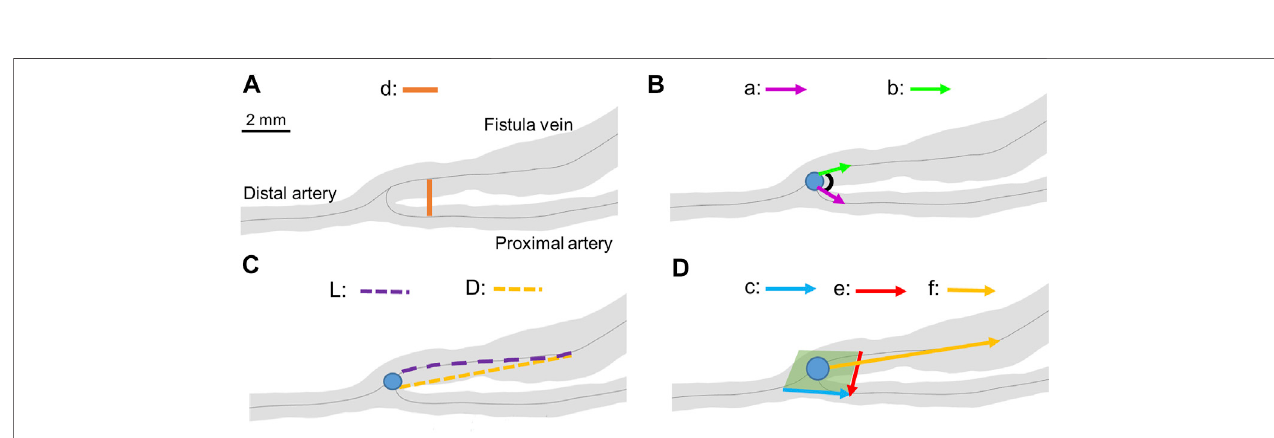
FIGURE 3 | Geometrical parameter calculations. (A) A-V distance. “ d ” represents the distance between the proximal artery and the fi stula vein. (B) Anastomosis angle. “ a ” representsvectorfromtheanastomosisorigin(bluedot)toapoint2 mmawayintheproximalartery. “ b ” representsthevectorfromtheanastomosisorigintoa point 2 mm awayin the fi stulavein. (C) Tortuosity. “ L ” represents the curvedlengthofthecenterlinetoapoint 6.5 mmaway from theanastomosis origin. “ D ” represents the straight-line length to apoint 6.5 mm away from the anastomosis origin. (D) Nonplanarity angle. The green plane representsthe plane created from vectors “ c ” and “ e ” . “ f ” represents the vector from the anastomosis angle to a point 6.5 mm away in the fi stula vein. The blue dots represent the anastomosis origin in all